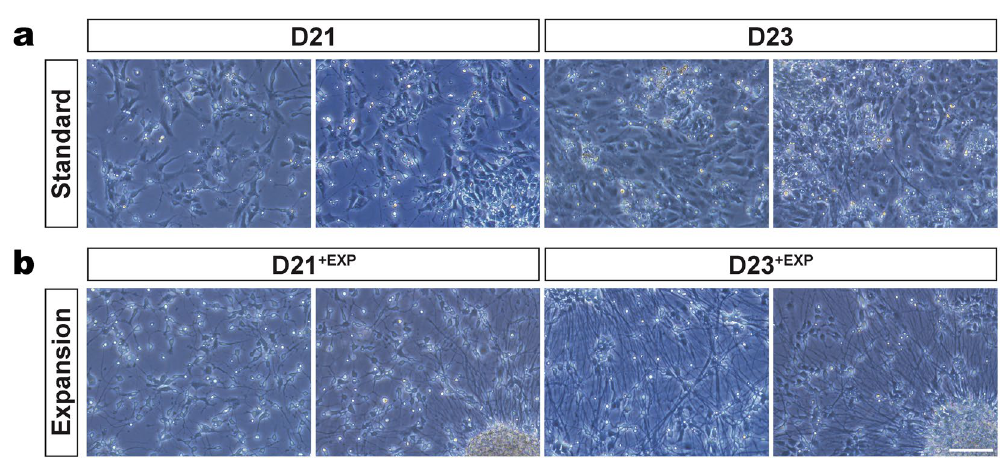
Figure 4. Typical cell morphology in DA neuron cell cultures obtained by using the standard and the expansion methods. ( a ) Phase image of cells after 21 (D21) and 23 days (D23) of differentiation using the standard protocol. ( b ) Phase image of cells after 21 + EXP (D21 + EXP ) and 23 + EXP (D23 + EXP ) days of differentiation using the expansion protocol. Using the expansion method, higher numbers of cells with typical neuronal morphology were generated. At D23 + EXP , a thick net of cells with long processes could be observed, suggesting the higher efficiency of expanded progenitor-derived DA neuronal differentiation compared to the standard method. Scale bars: 100 μ